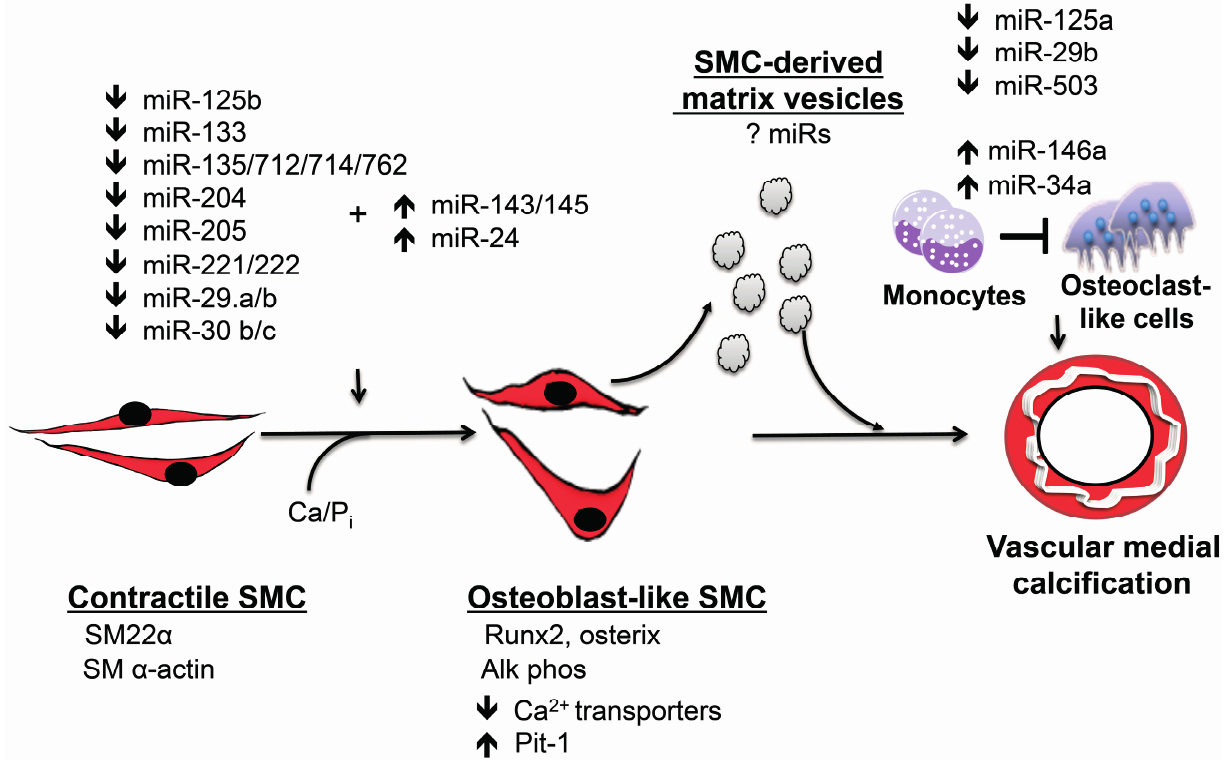
Figure 1. miRs regulate vascular medial calcification. miRs play an integral role in regulating vascular medial calcification by initiating vascular smooth muscle transition to calcifying vascular cells that express the master osteoblast transcription factors, Runx2 and osterix. These osteoblast-like cells also express alkaline phosphatase and elaborate bone matrix. Smooth muscle cell transdifferentiation occurs concomitant with the downregulation of smooth muscle cell contractile proteins. Calcifying smooth muscle cells generate matrix vesicles that contribute to vascular medial calcification by serving as a nucleation site for calcium phosphate. These matrix vesicles may also carry miRs that regulate phenotype in other cells. miRs also inhibit osteoclastogenesis and likely limit the bone resorptive capacity of osteoclast-like cells in the vessel wall to promote vascular calcification. This system has significant redundancy, and several miRs target the same protein or signaling